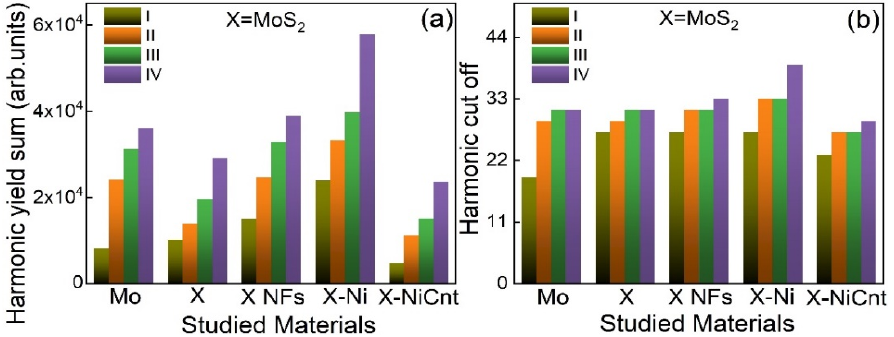
Figure 6. ( a ) Harmonic cut-offs and ( b ) harmonic yields at various intensities of heating and driving pulses (I: 2.1 × 10 9 W/cm 2 and 1.3 × 10 14 W/cm 2 ; II: 3.4 × 10 9 W/cm 2 and 2.5 × 10 14 W/cm 2 ; III: 5.4 × 10 9 W/cm 2 and 3.4 × 10 14 W/cm 2 ; IV: 7.3 × 10 9 W/cm 2 and 4.7 × 10 14 W/cm 2 , X: MoS 2 ). At 2.1 × 10 9 W/cm 2 (HP) and 1.3 × 10 14 W/cm 2 (DP) intensities, Mo bulk-contained